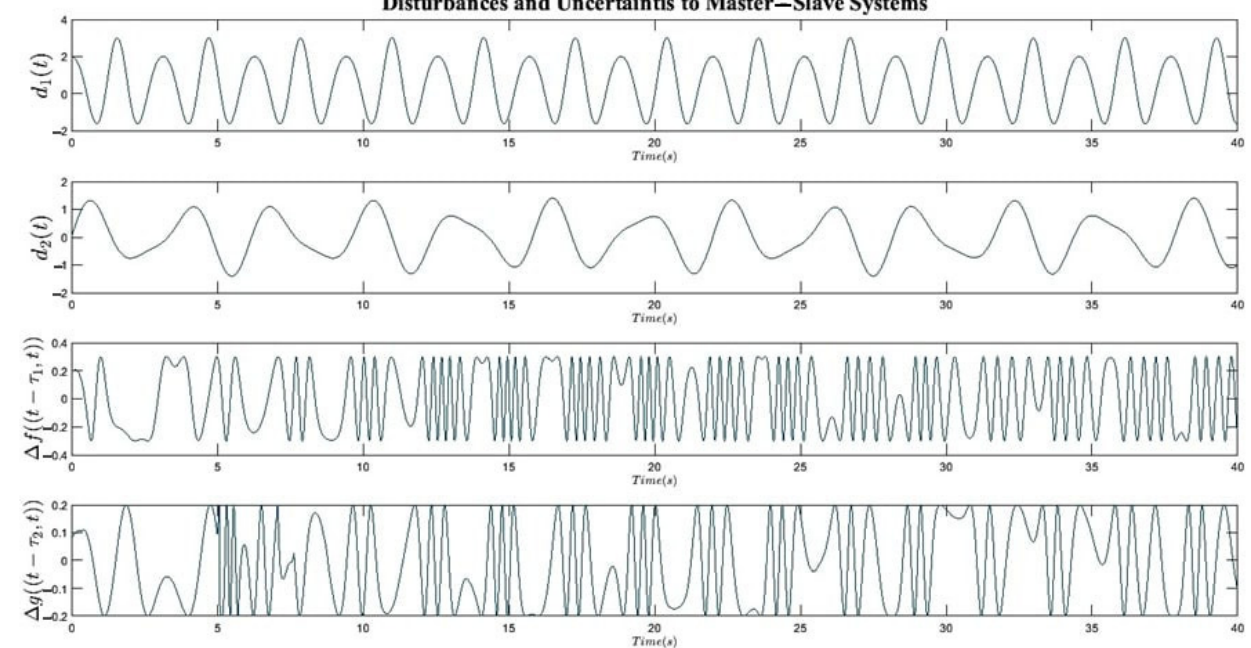
Figure 6. Estimation error of the system parameters.